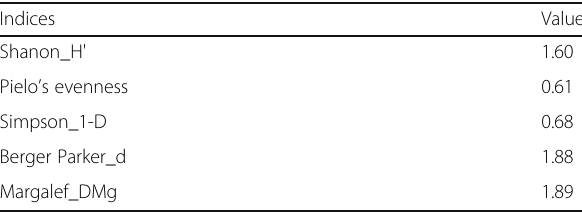
Table 2 Species diversity and species richness indices calculated for insects associated